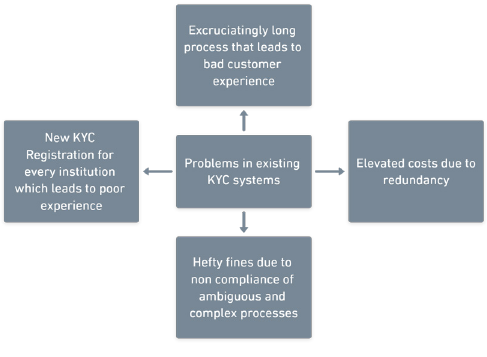
Fig. 1 . Problems in current KYC